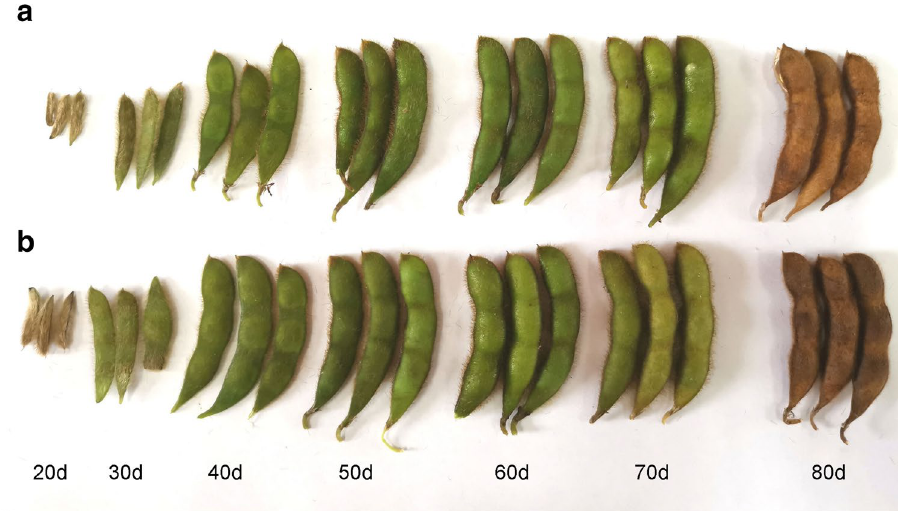
Figure 13. Soybean [ Glycine max (L.) Merr] materials used in this study. samples were taken seven times from 20 to 80 d after soybean flowering. ( a ) Low-linolenic acid mutant ‘MT72 ′ , ( b ) Control material